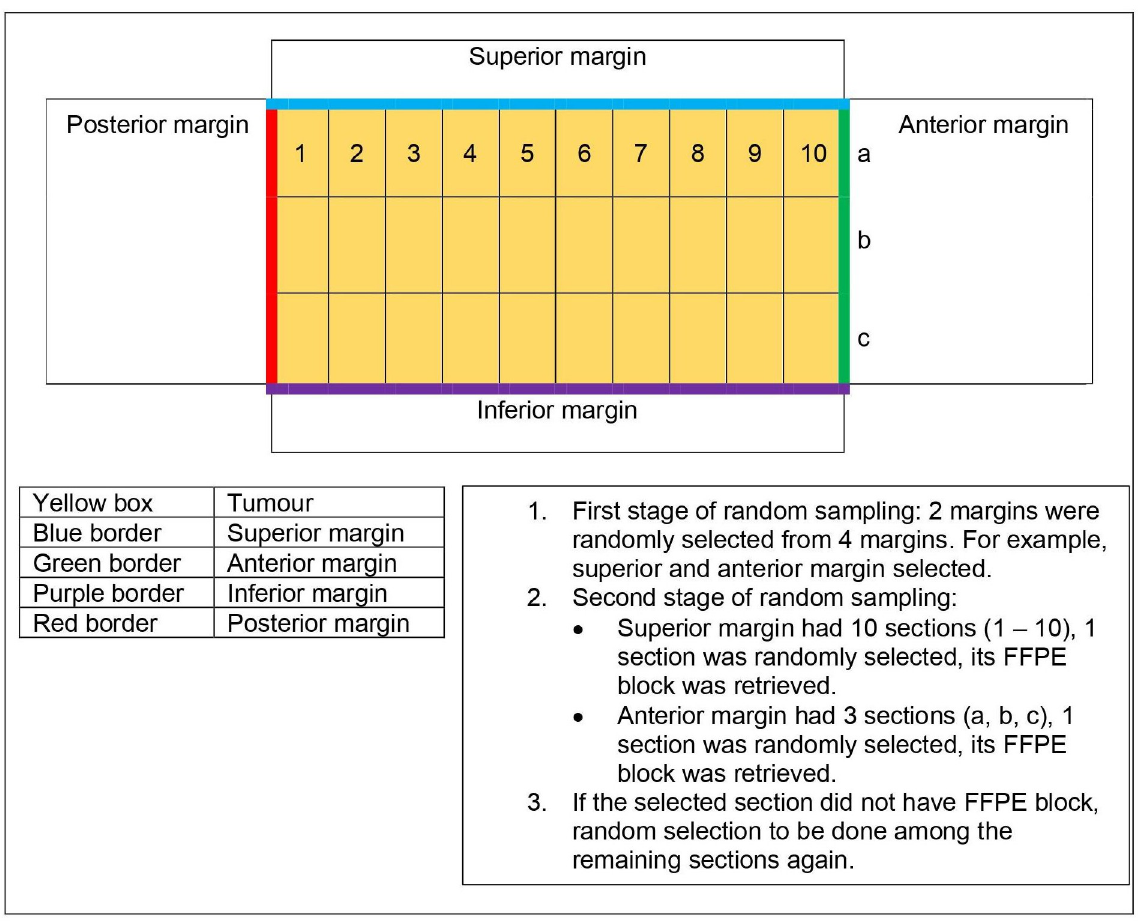
Fig 1. Illustration and protocol of random